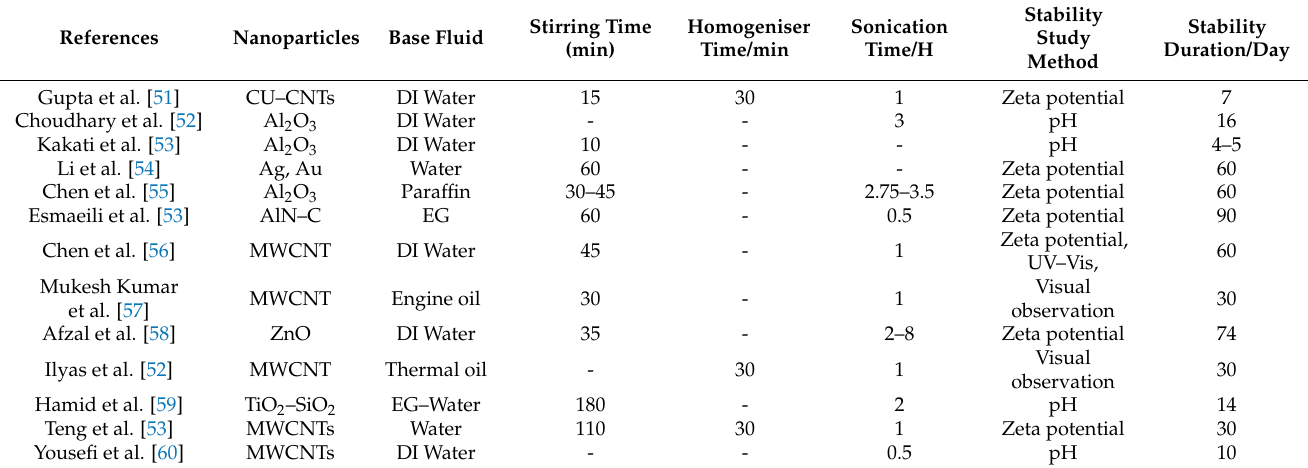
Table 2. Comparison of stability of nanofluid with respect to the preparation